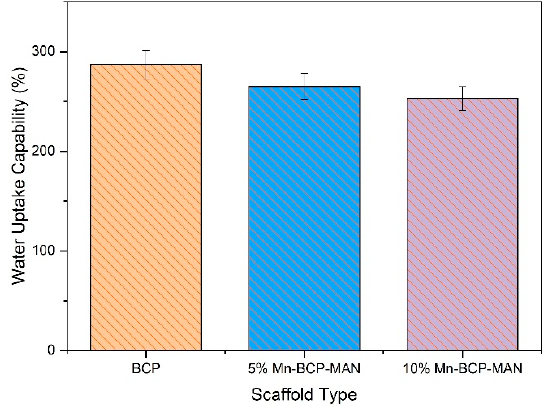
Figure 3. Water uptake capability of the scaffolds.